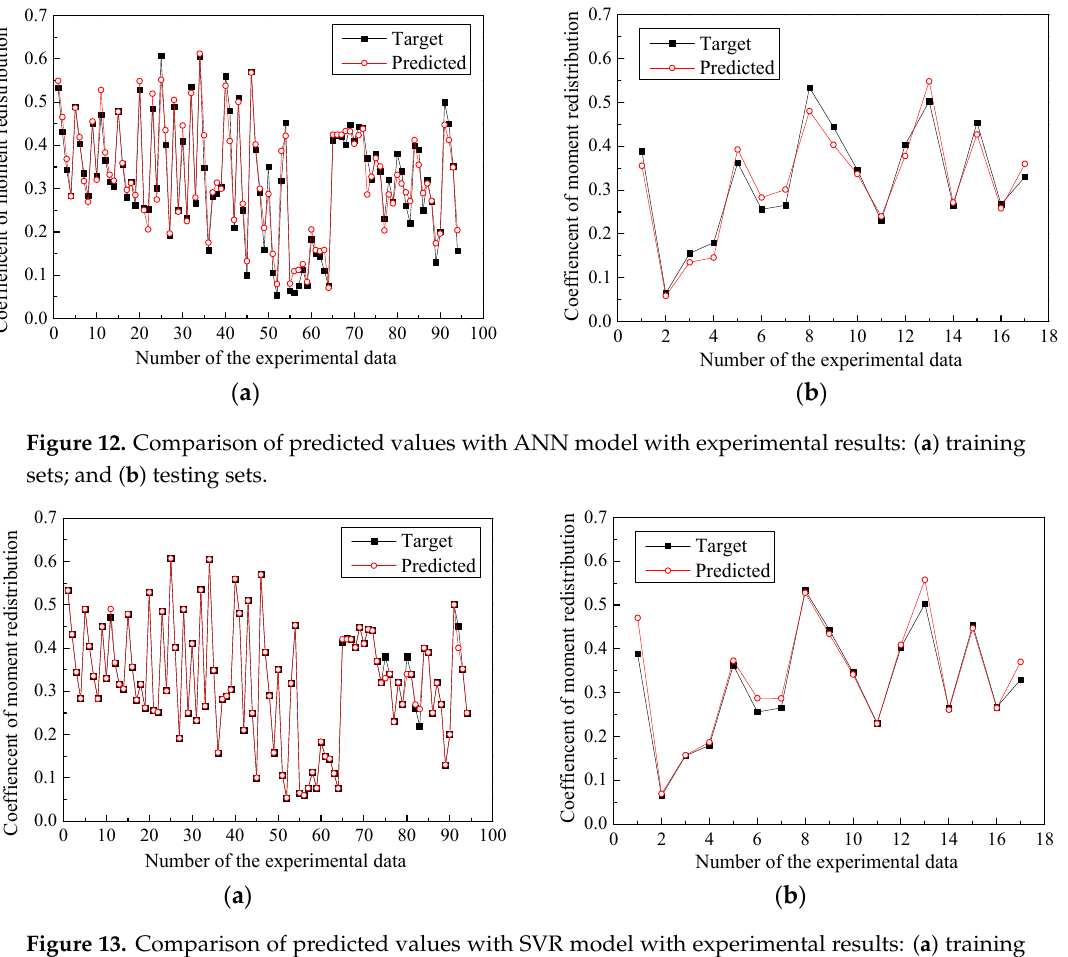
Figure 13. Comparison of predicted values with SVR model with experimental results: ( a ) training sets; and ( b ) testing sets.